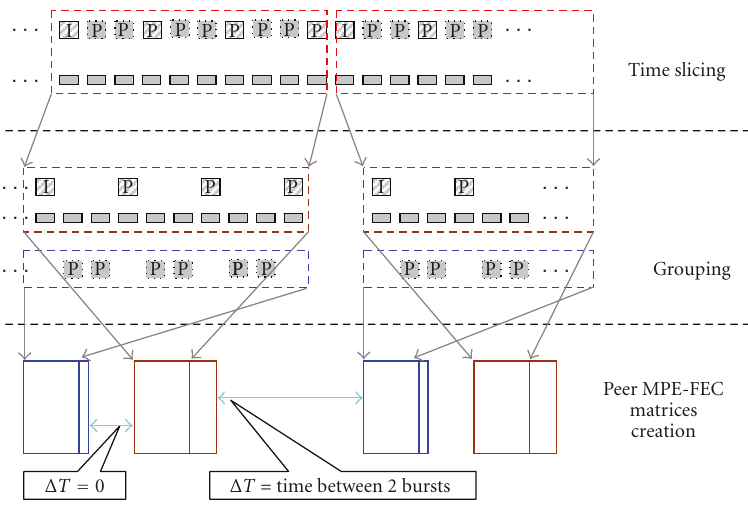
Figure 4: Priority assignment and peer matrix creation using video subsequences.